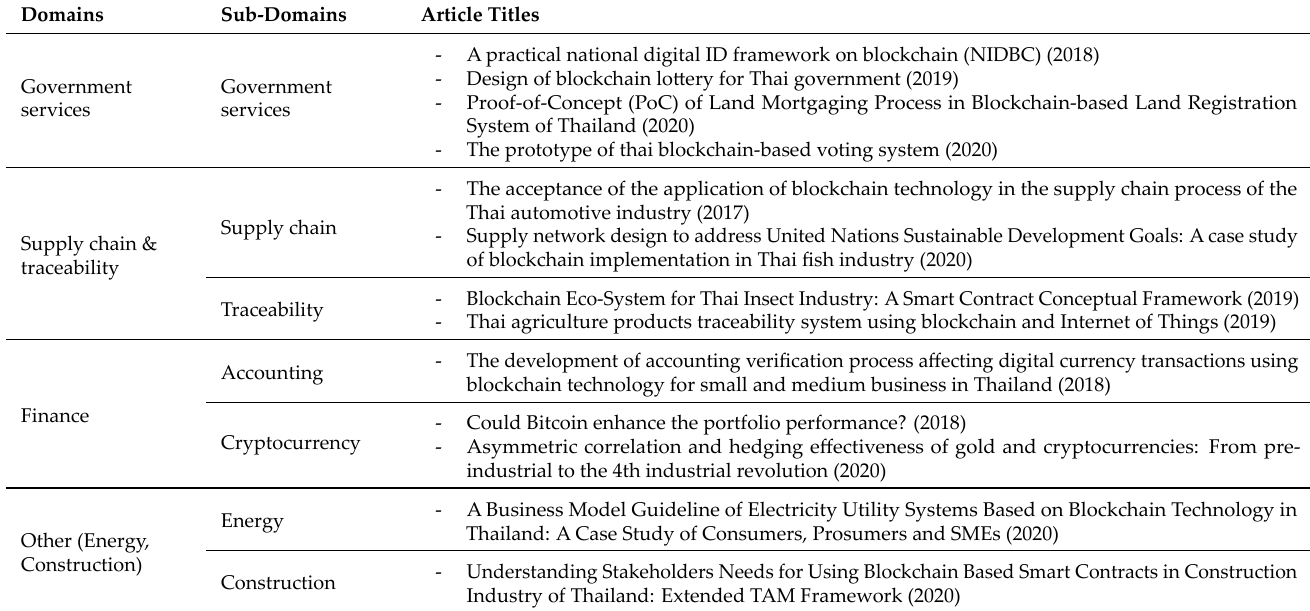
Table 2. Articles categorized by domains and